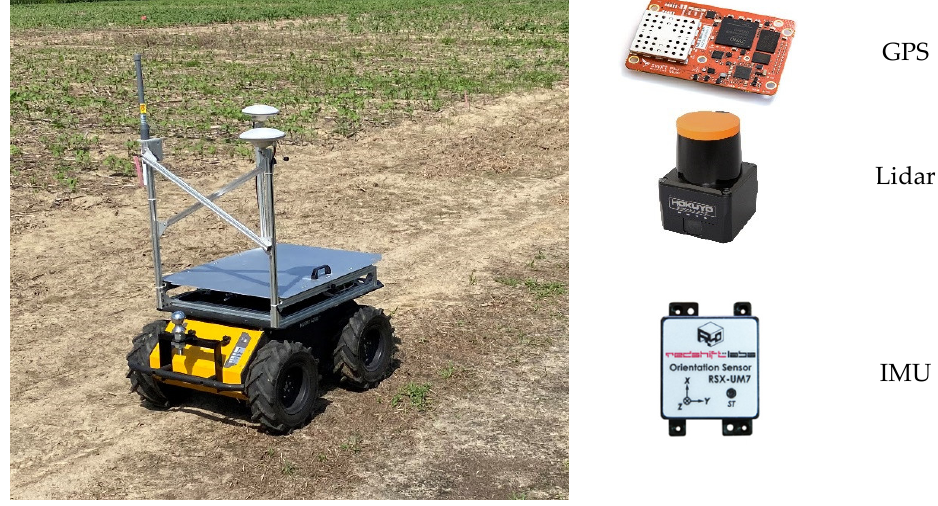
Figure 1. Mobile robot platform used in this project.